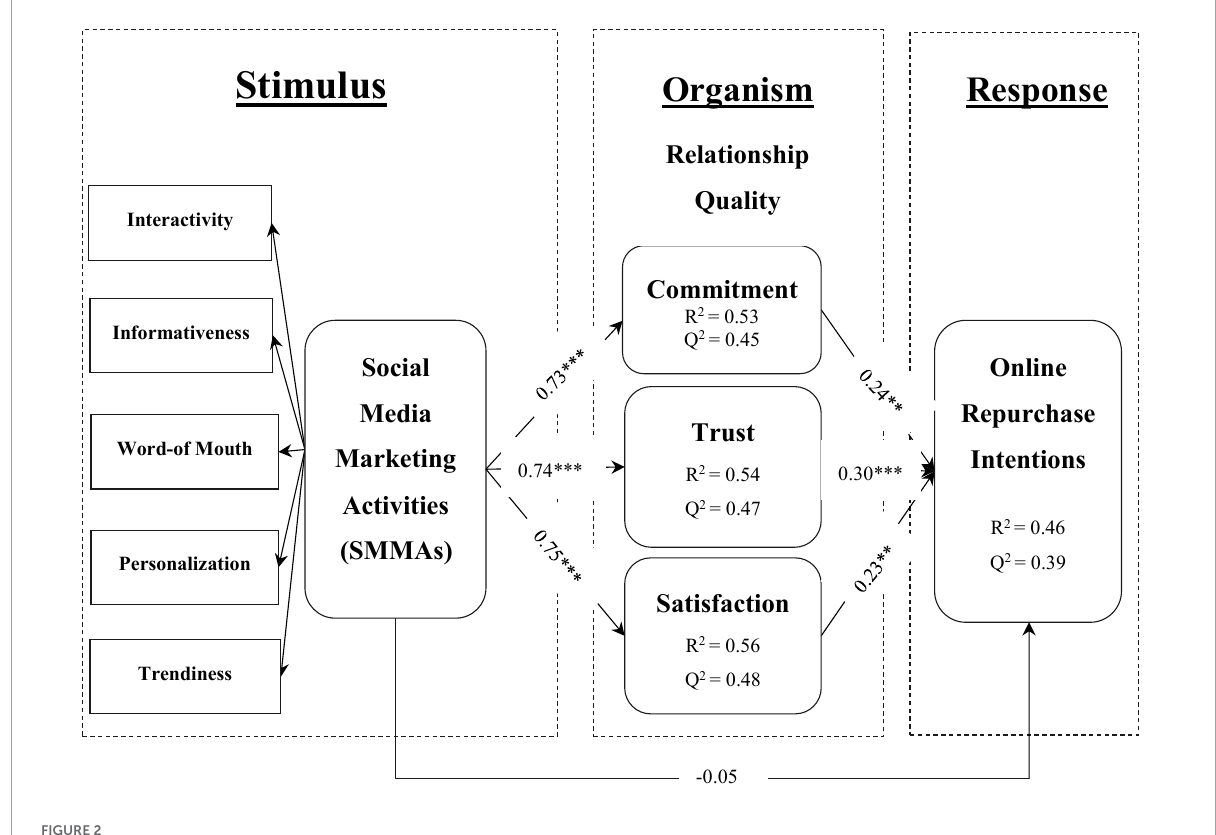
FIGURE2 Structural model significance, R 2 and Q 2 -values. ( t > 2.58 at ** p < 0.01); ( t > 3.29 at *** p < 0.001);